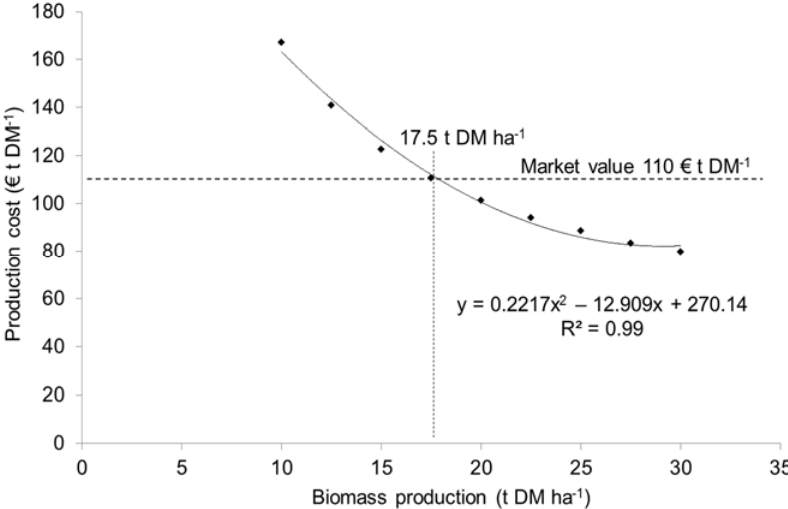
Figure 7. Woodchip production cost as a function of biomass production.